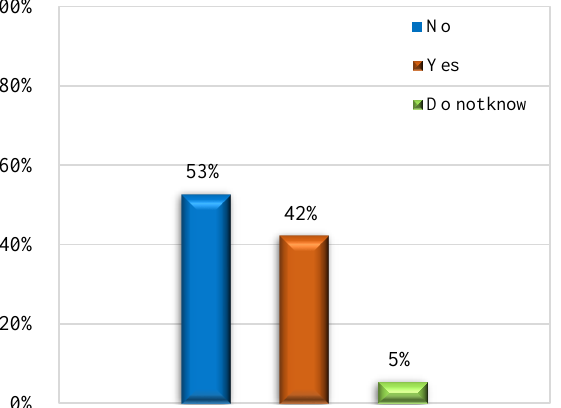
Figure 11. Comparison of combined results regarding necessity of higher competence and more experience in wooden frames considered by ERs and UERs.